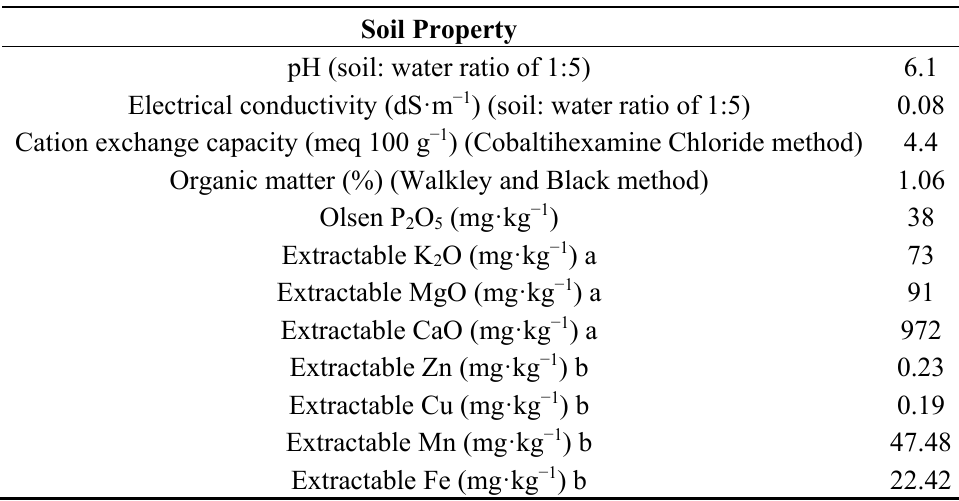
Table 1. Physicochemical properties of the soil. Soil